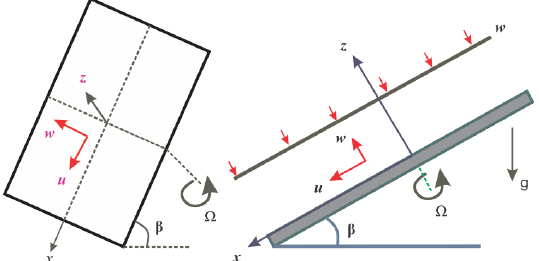
Figure 1. Geometrical demonstration of the physical